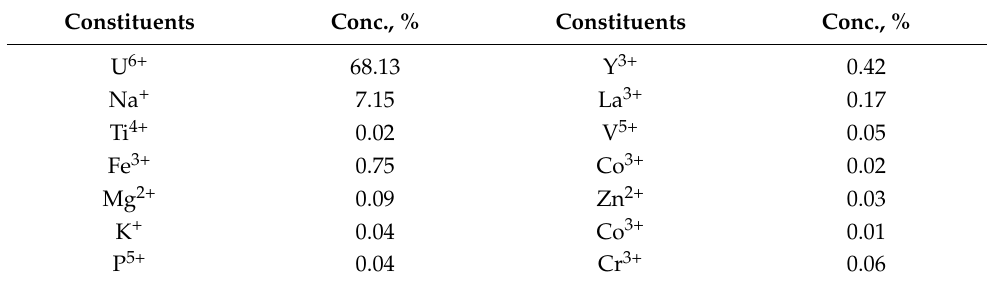
Figure 11. ( a ) The scanning electron microscope, EDX, and ( b ) XRF of sodium diuranate analysis. Table 7. Chemical analysis of sodium